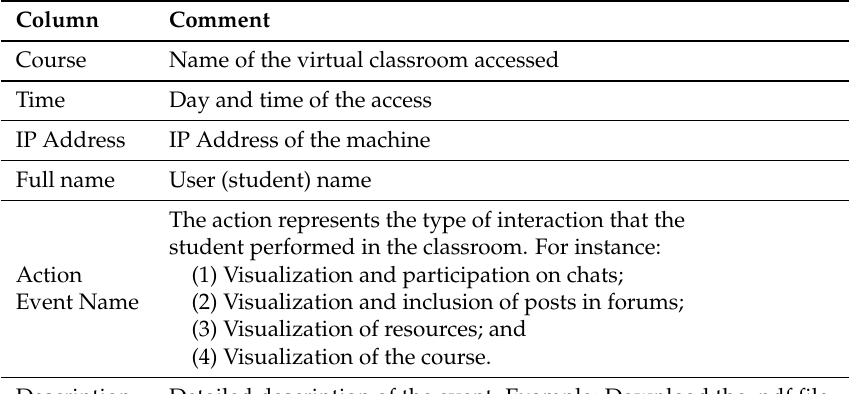
Table 2. Information contained in the log